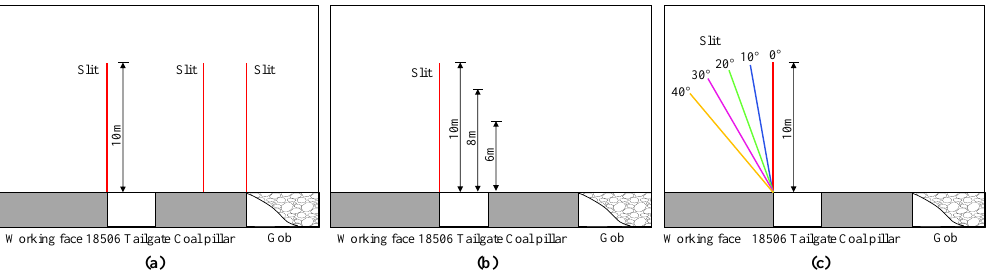
Figure 8. Schematic diagram of simulation scheme: ( a ) different cutting positions; ( b ) different cutting heights; ( c ) different cutting angles.